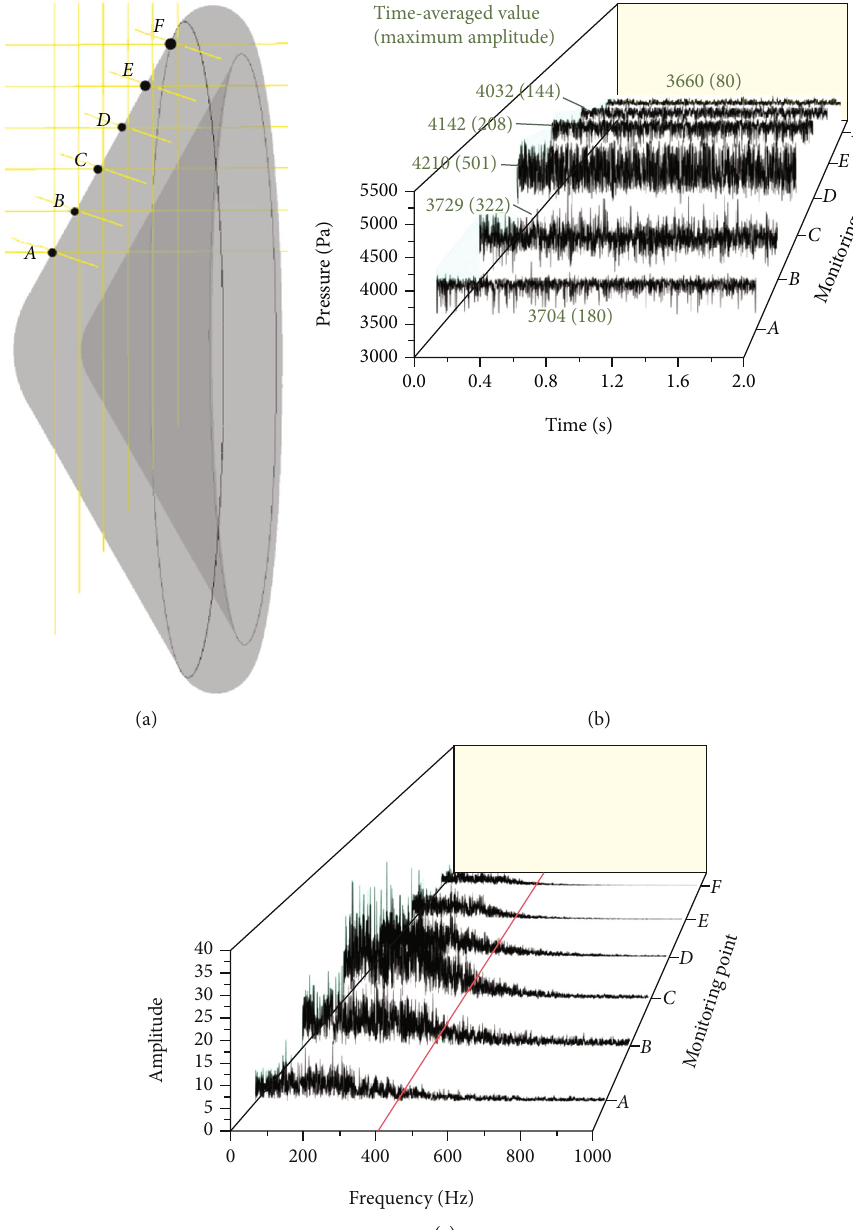
Figure 12: Pressure fl uctuation and frequency spectrum: (a) monitoring points; (b) pressure fl uctuation; (c) frequency